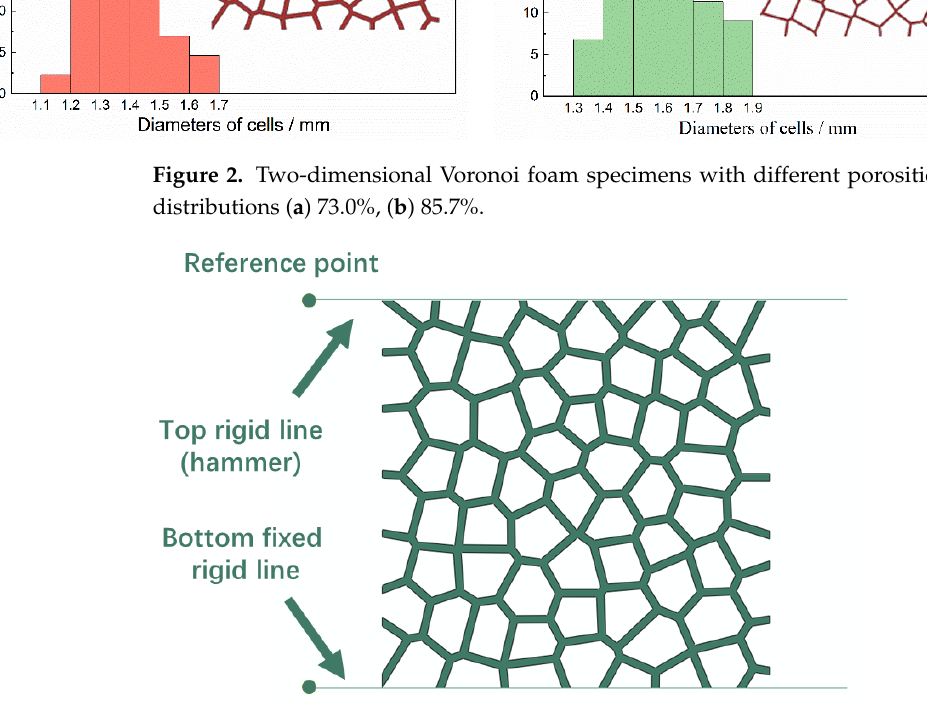
Figure 3. The schematic of simulation conditions.